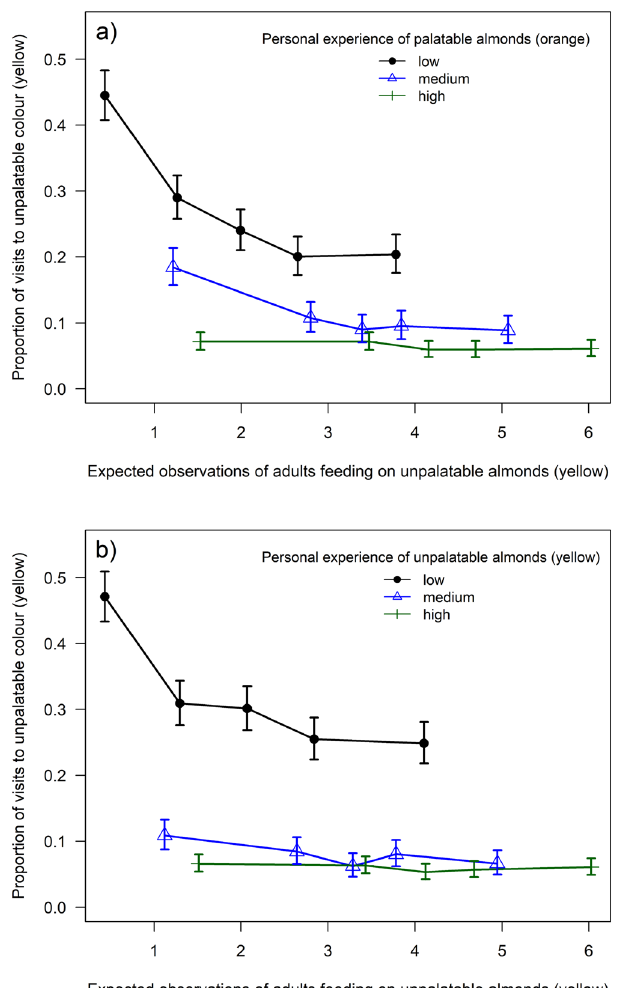
Fig. 3 The effect of social information on birds ’ foraging choices. The proportion of birds ( n = 168) choosing the unpalatable (yellow) option in the yellow/orange experiment after observing adults feeding on unpalatable almonds. Social information reduced the likelihood to choose the unpalatable color when birds had little personal experience of ( a ) palatable or ( b ) unpalatable almonds (circles and black lines). For illustration purposes, the data is divided into ‘ personal experience categories ’ (represented by different symbols and colors) based on how many times birds had personally sampled palatable ( a ) or unpalatable ( b ) almonds before their current choice, standardized within each bird to allow us to show the within-bird patterns detected by the model. ‘ Low personal experience ’ includes data from birds within the 1st quartile for this variable, ‘ medium ’ birds within the 2nd quartile, and ‘ high ’ birds within the 3rd or 4th quartile. Within these ‘ personal experience categories ’ , the data is further split into categories based on the expected number of observed unpalatable feeding events of adults. Symbols show the mean and 95% CI for the proportion of birds choosing the unpalatable option. See Supplementary Figs. 1 and 2 for the other two color